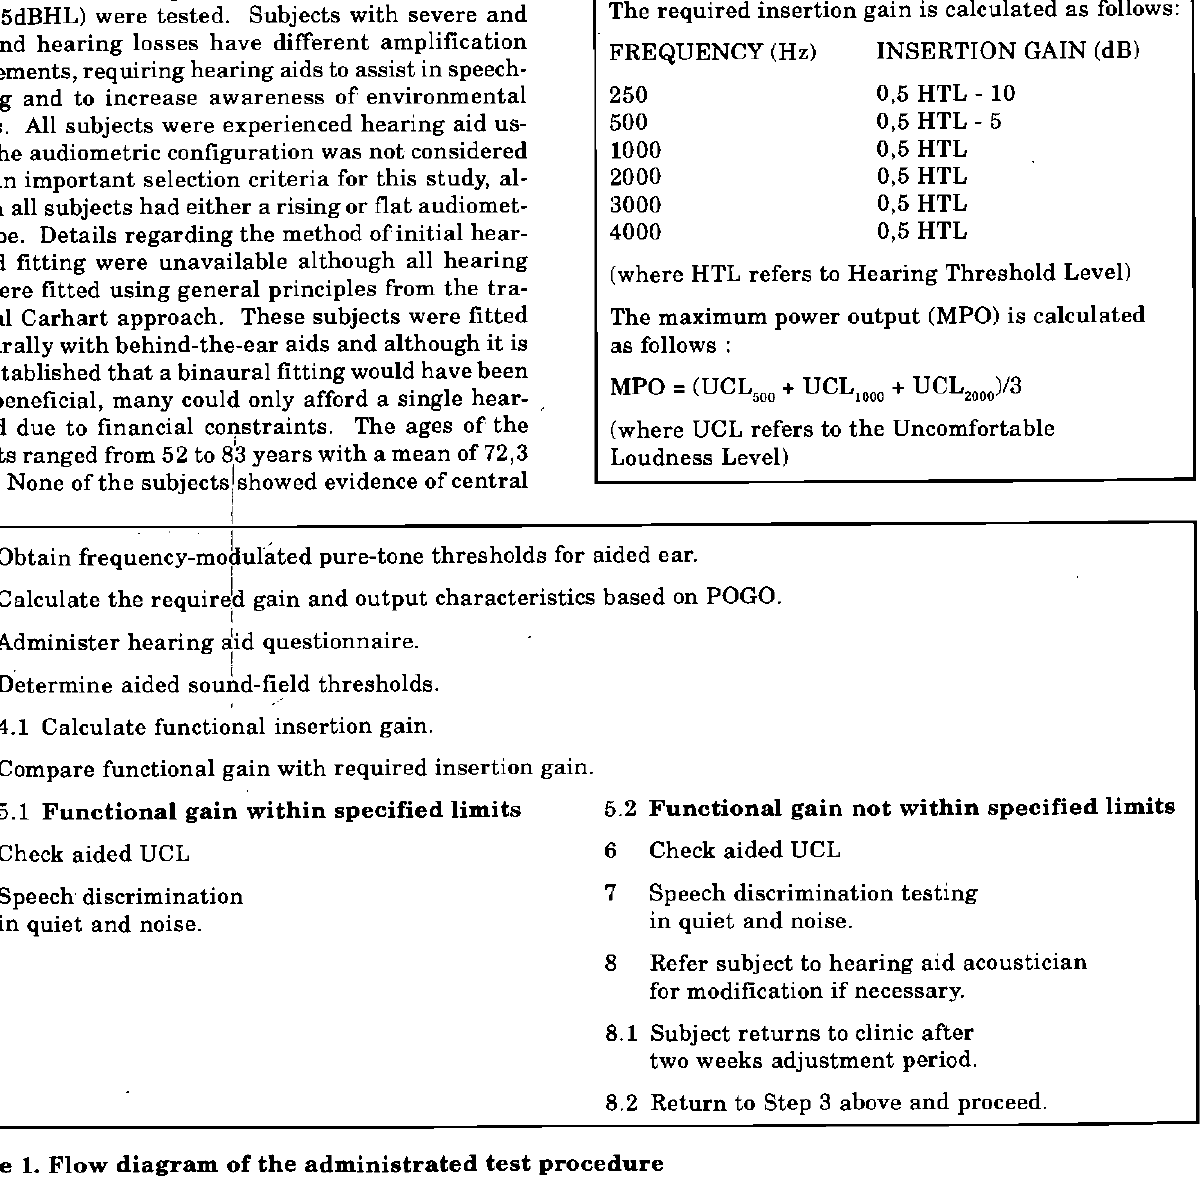
Figure 1. Flow diagram of the administrated test procedure Die Suid-Afrikaanse Tydskrif vir